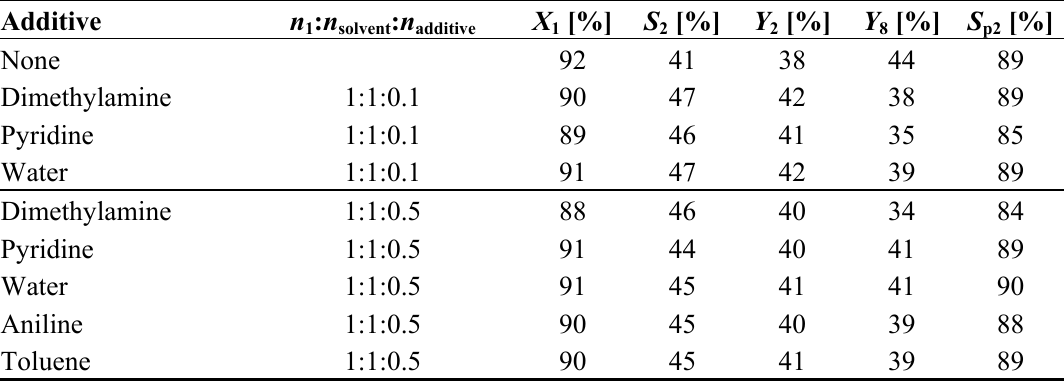
Table 3. Conversion X definition see Figure 4) for the pyrolysis of 1 with different additives at T = 525 °C a